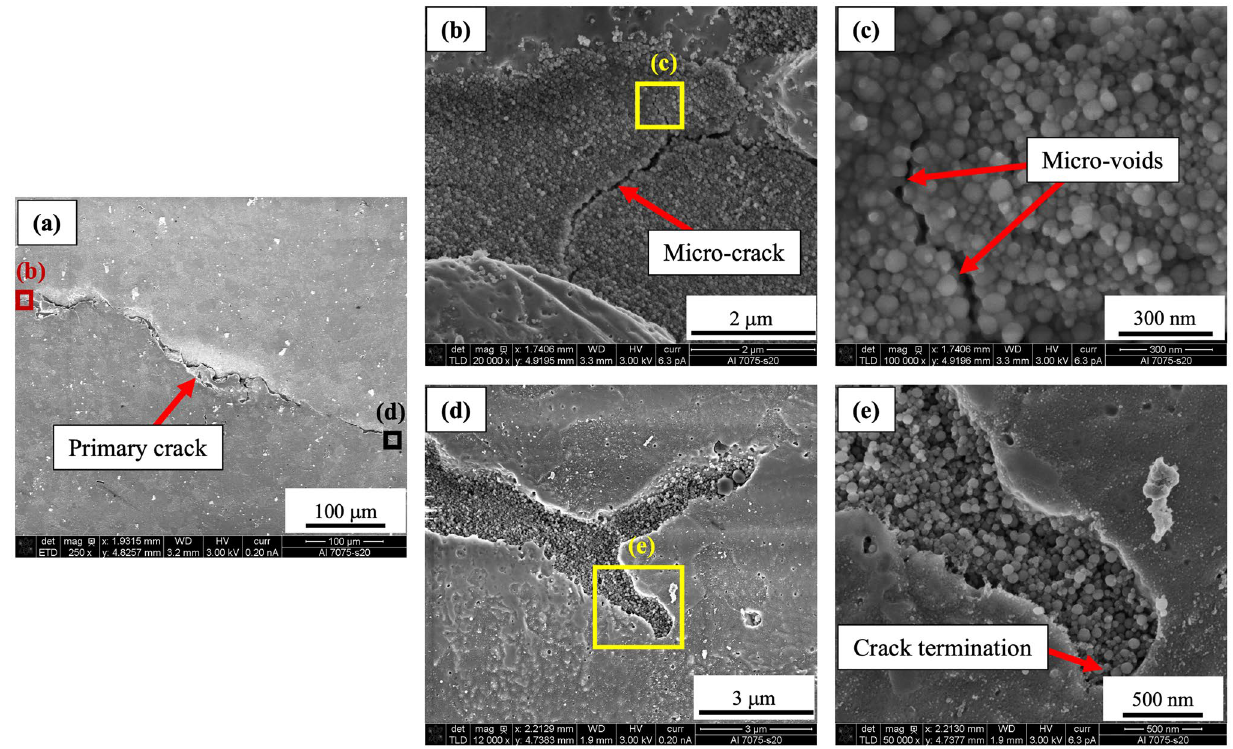
box in ( b ), ( d ) termination of crack inside the area enclosed by black box in ( a ), and ( e ) zoomed-in image of the area enclosed by yellow box in ( d ) showing the crack termination